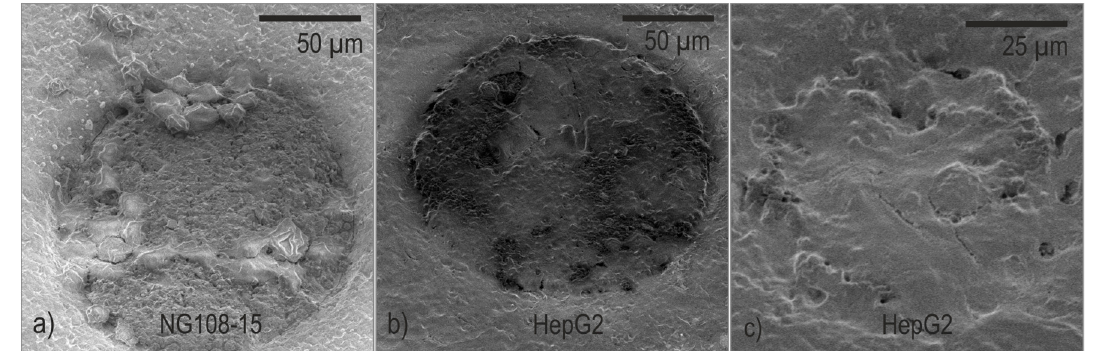
Figure 9. SEM micrographs of fixed cells on PEDOT-MEAs: ( a ) NG108-15 spheroid cell agglomerates; ( b ) Hep-G2 cells partially covering the electrode; ( c ) Hep-G2 cells densely covering a small electrode with 86 µm diameter.